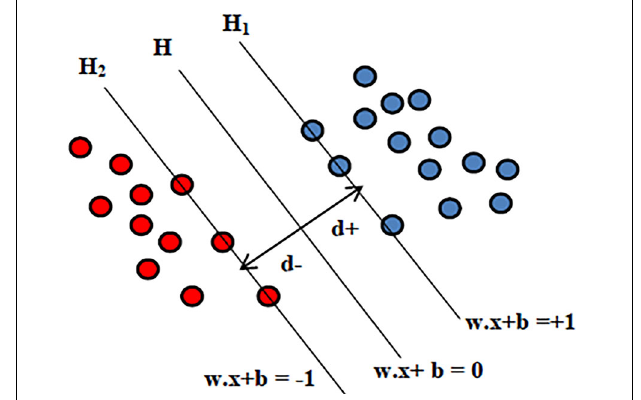
FIGURE 3 | Illustration of SVM